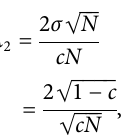
Frontiers in Applied Mathematics and Statistics |